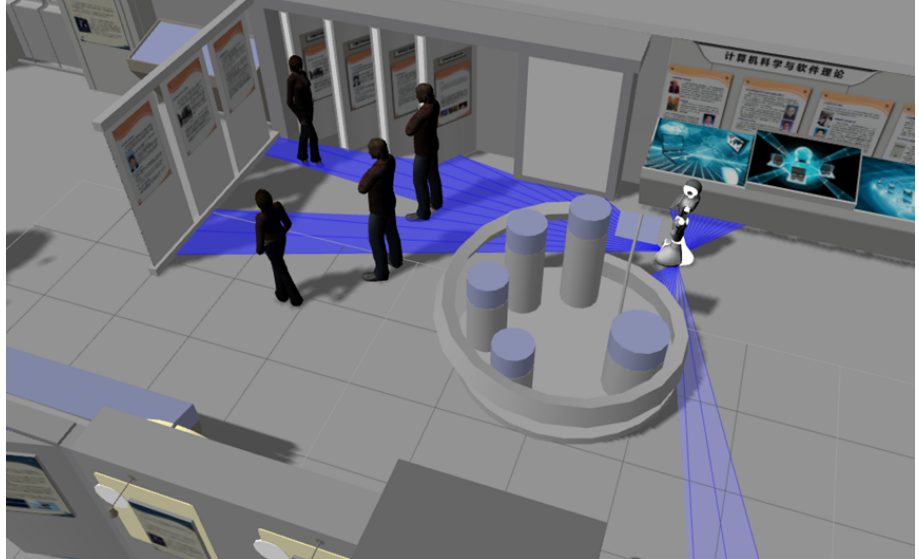
Figure 11. Group of people paying attention to one